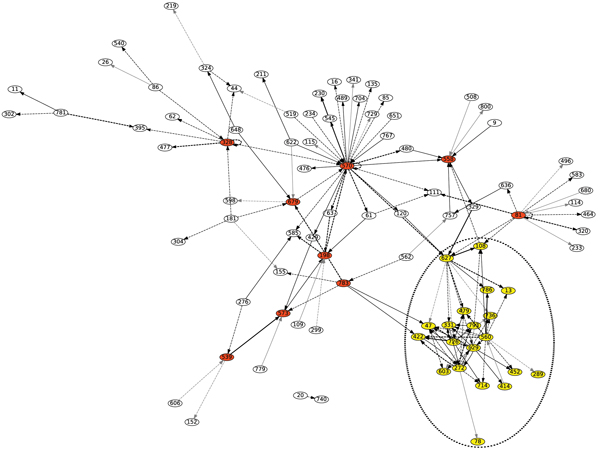
Directed VAR network inferred from the Arabidopsis thaliana data. The solid and dotted lines indicate positive and negative regression coefficients, respectively, and the line intensity denotes their strength. For annotation of the nodes see the Supplementary Information, Table 1. The color code of the nodes is explained in the main text.